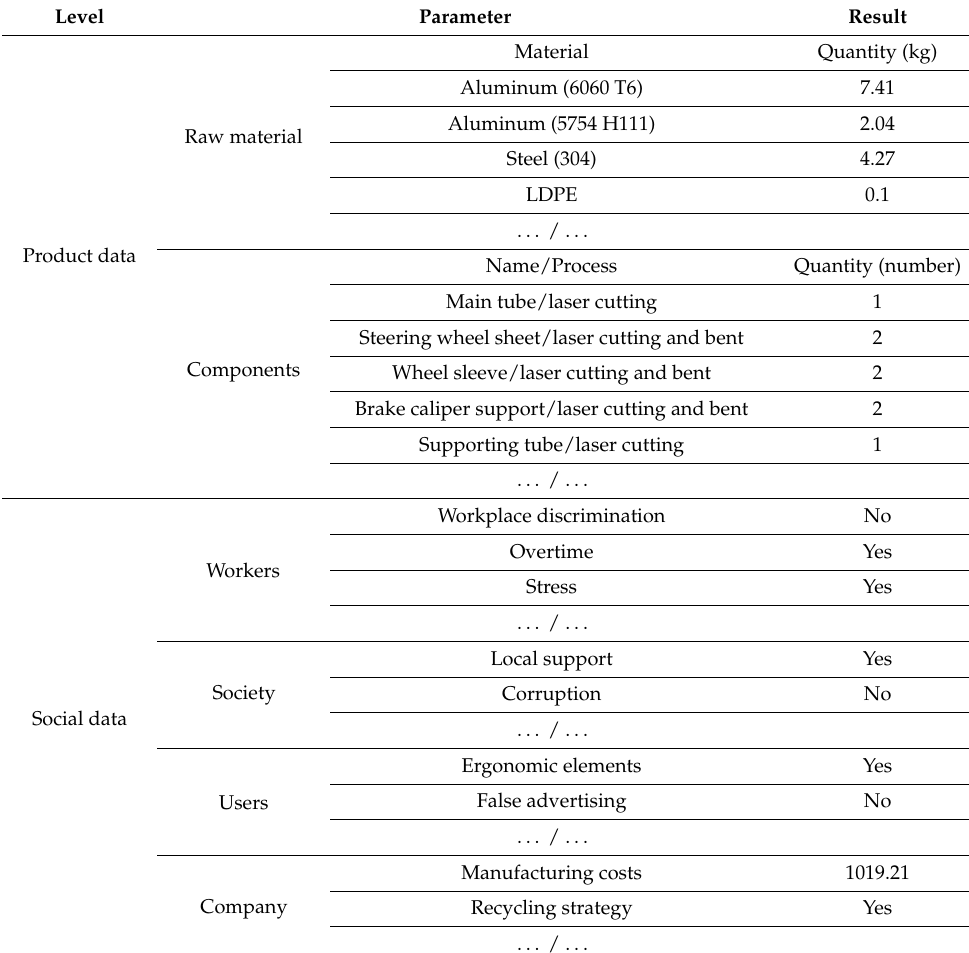
Table 3. Summarized Life Cycle Inventory (LCI).